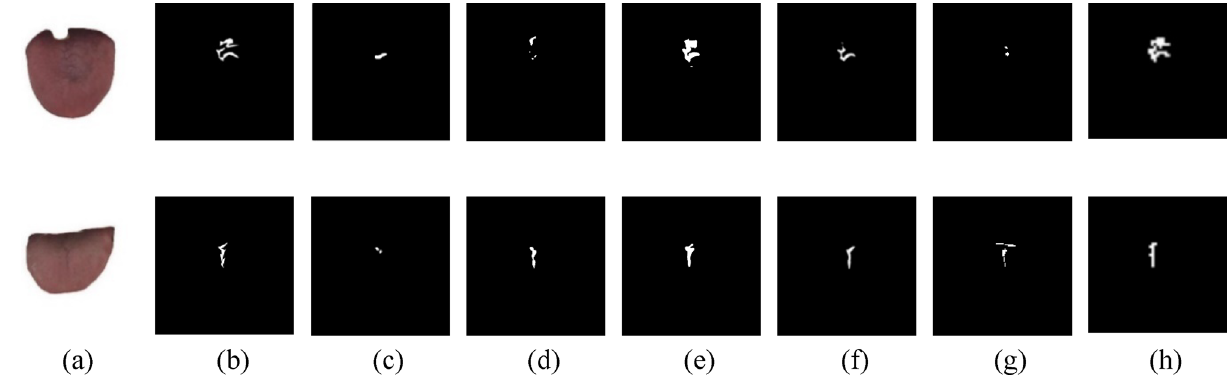
Figure 7. Segmentation results of different models. ( a ) Original images of tongue crack; ( b ) Ground truth images of tongue crack; ( c ) Segmentation results of Mask R-CNN 16 ; ( d ) Segmentation results of DeeplabV3+ 17 ; ( e ) Segmentation results of U-Net 18 ; ( f ) Segmentation results of UNet++ 19 ; ( g ) Segmentation results of SegAN 20 ; ( h ) Segmentation results of SBDL.